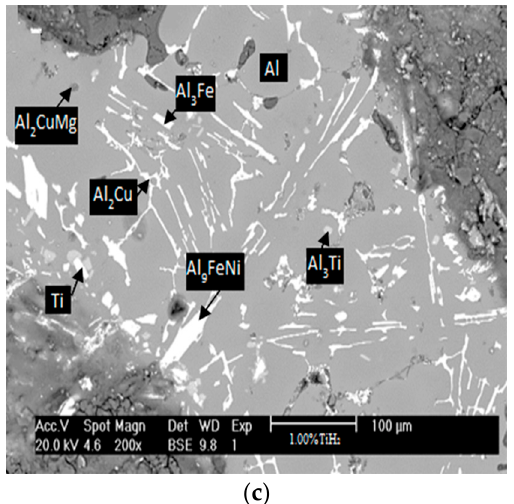
Figure 8. Micrographs of A-242 aluminium alloy foams: ( a ) 0.50 wt.% TiH 2 ; ( b ) 0.75 wt.% TiH 2 ; and ( c ) 1.00 wt.% TiH 2 at 948 K.